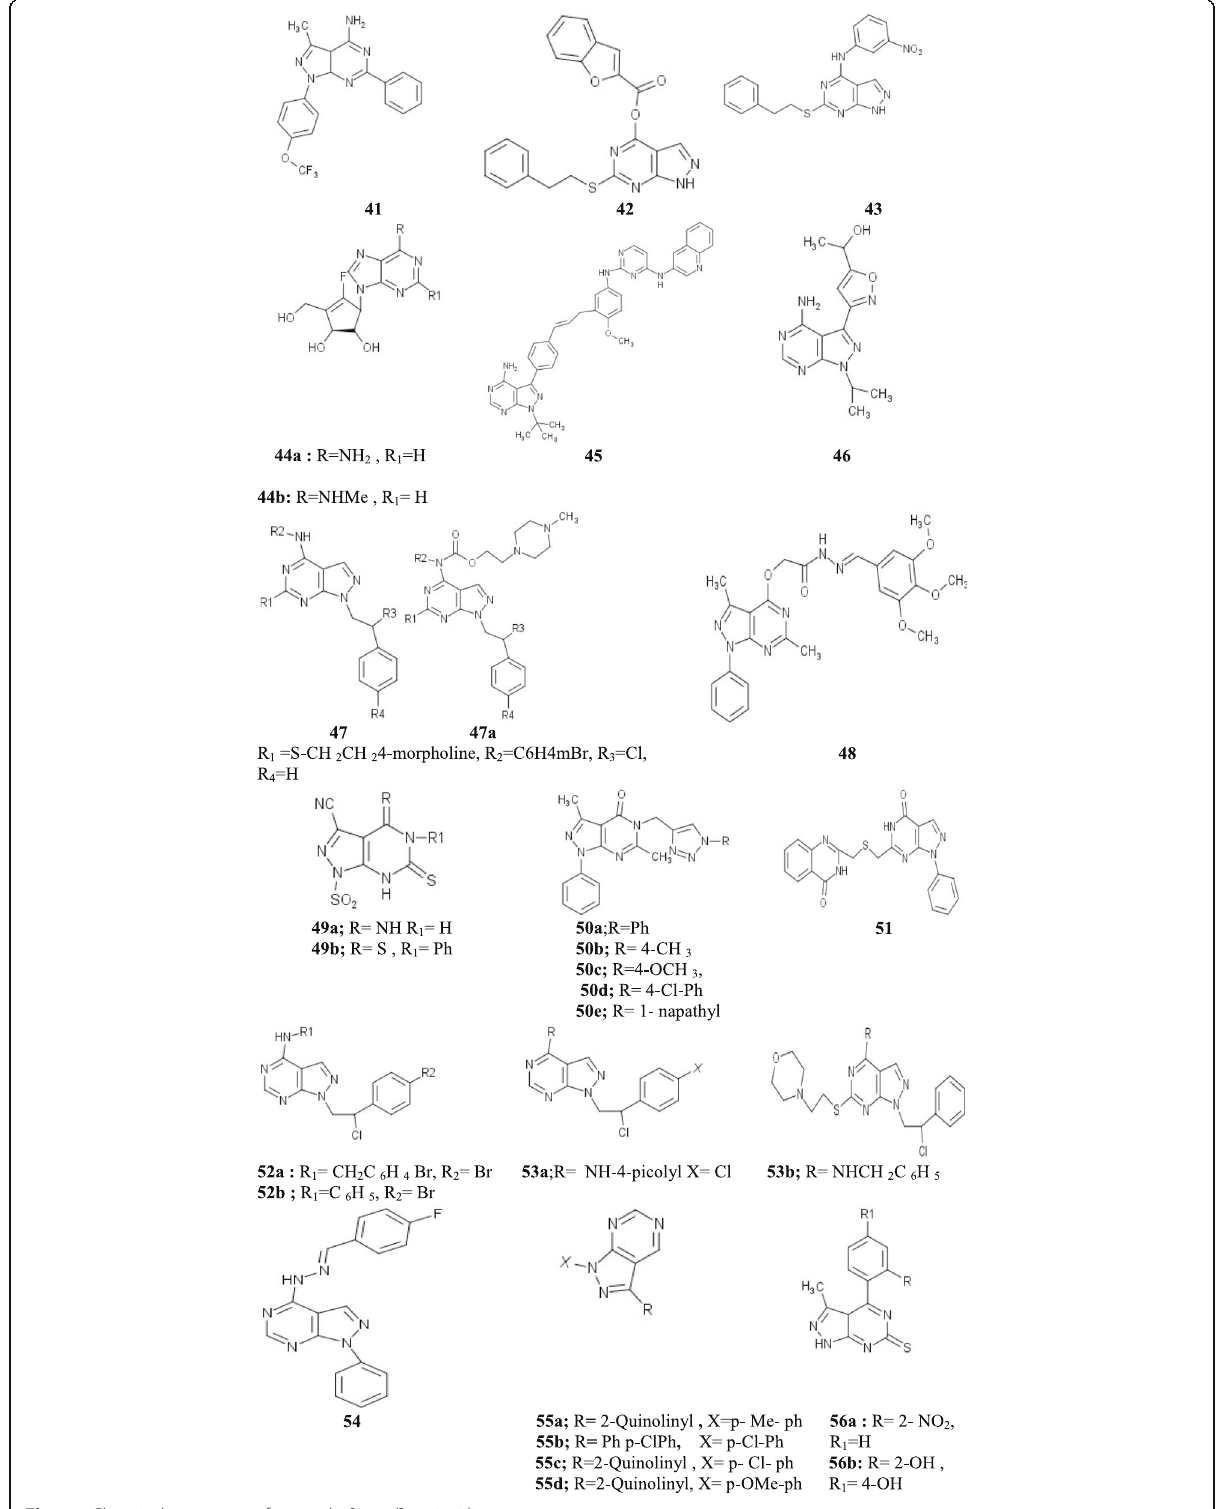
Fig. 17 Chemical structures of pyrazolo [3, 4-d]